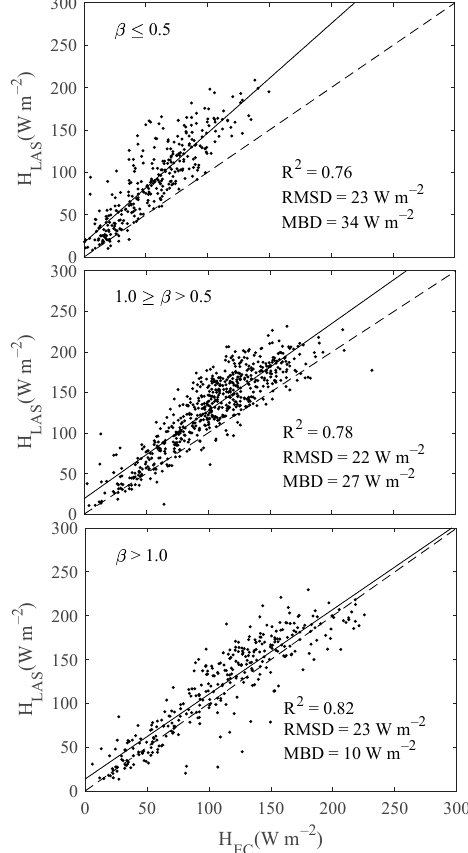
Figure 5. Comparison between H LAS and H EC at different β categories, with of β ≤ 0.5 ( top ), 1.0 ≥ β > 0.5 ( middle ), and β > 1.0 ( bottom ).